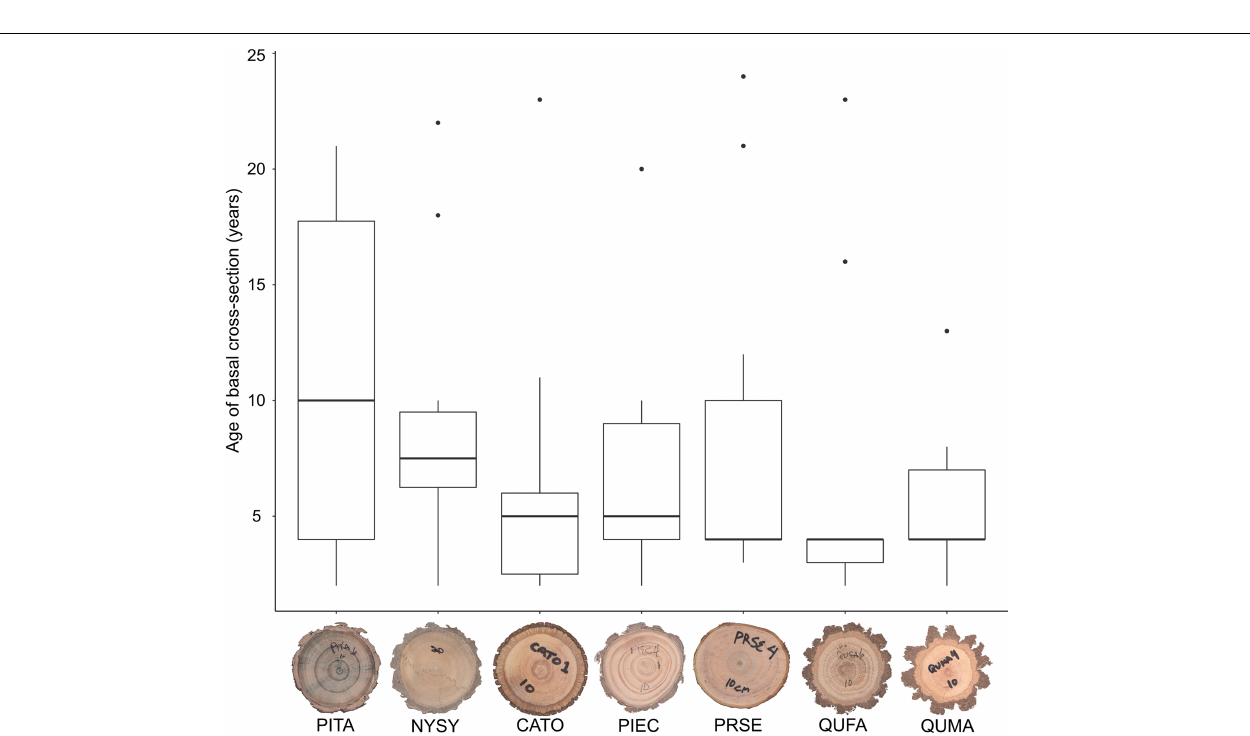
FIGURE 3 | Diameter of basal cross-sections in seven co-occurring tree species. Species codes are as follows: QUMA, Quercus marilandica ; QUFA, Quercus falcata ; PIEC, Pinus echinata ; PITA, Pinus taeda ; NYSY, Nyssa sylvatica ; CATO, Carya tomentosa ; PRSE, Prunus serotina . Horizontal bar in each boxplot represents the median diameter.